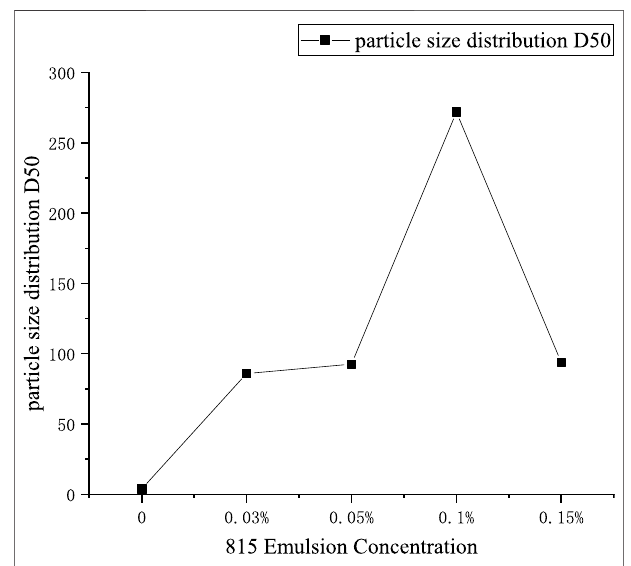
FIGURE5| In fl uenceofdifferentemulsionconcentrationsontheparticle size distribution in Biodrill-A drilling fl uid (D50). (A) Biodrill-A drilling fl uid. (B) Biodrill-A drilling fl uid treated with organic fl occulant.